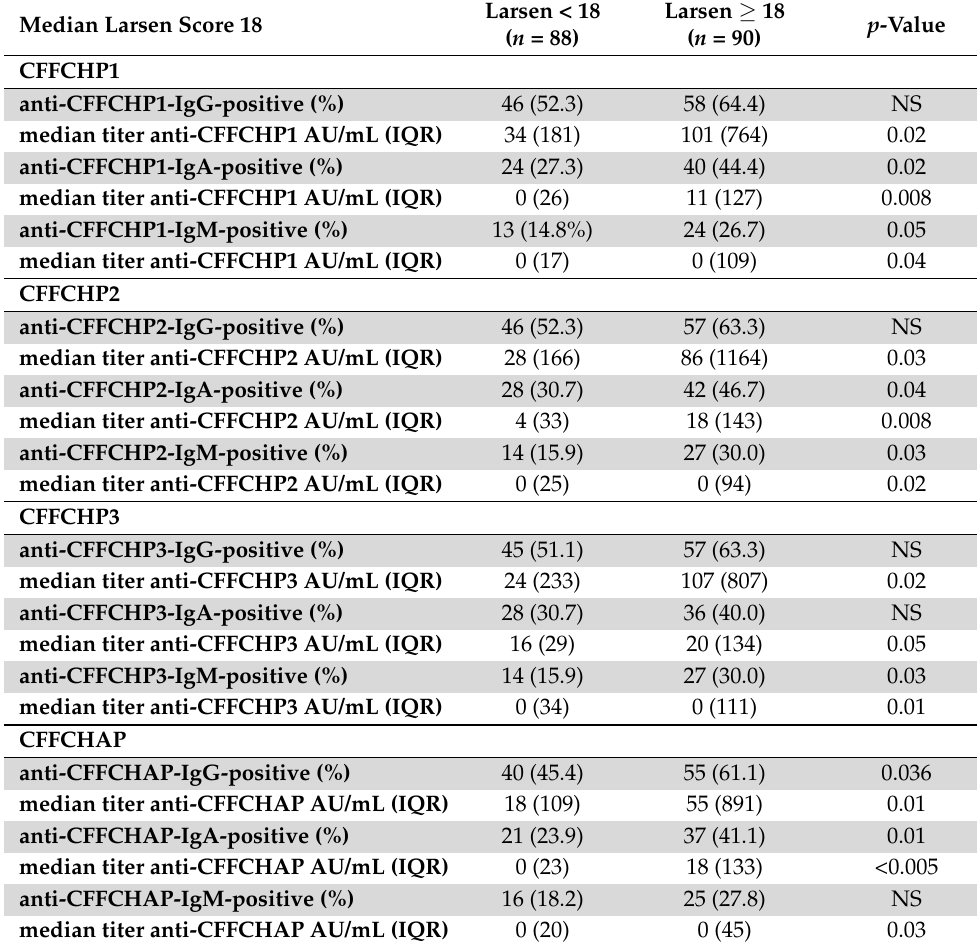
Table 4. Comparison of the presence of autoantibodies with the degree of joint destruction according to the modified Larsen